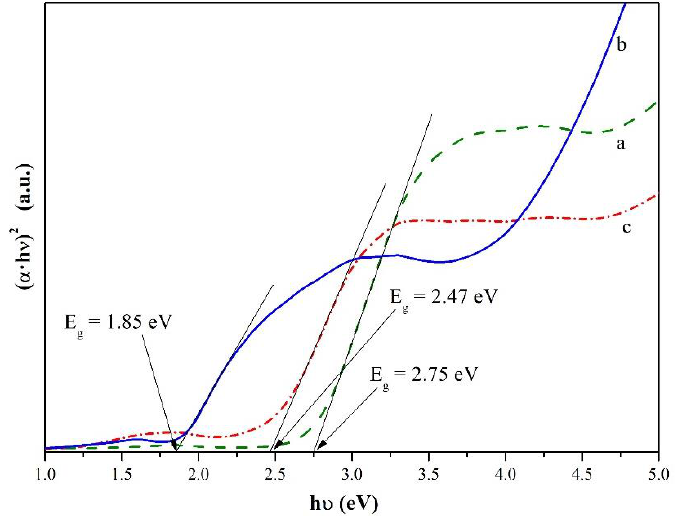
Figure 4. Estimated band gap energy of: ( a ) CuTa 2 O 6 (x = 0), ( b ) CuV 2 O 6 , ( c ) CuTa 1.70 V 0.30 O 6 (x = 0.30). The determined values of the band gap energy indicate that the new solid solution is a semiconductor.